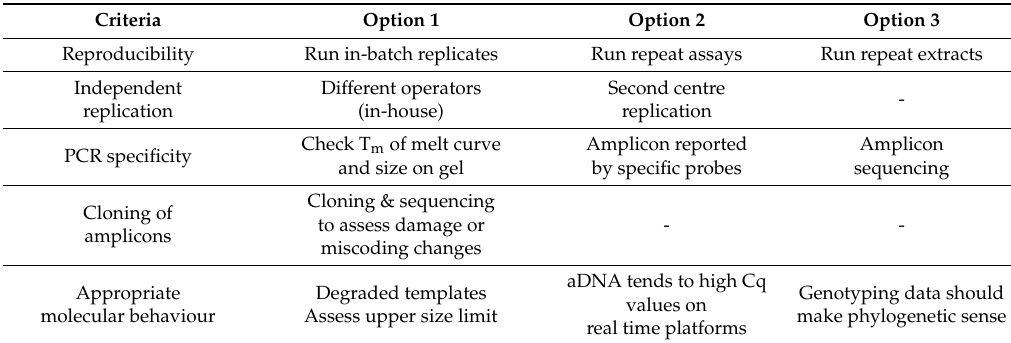
Table 4. Validation of aDNA